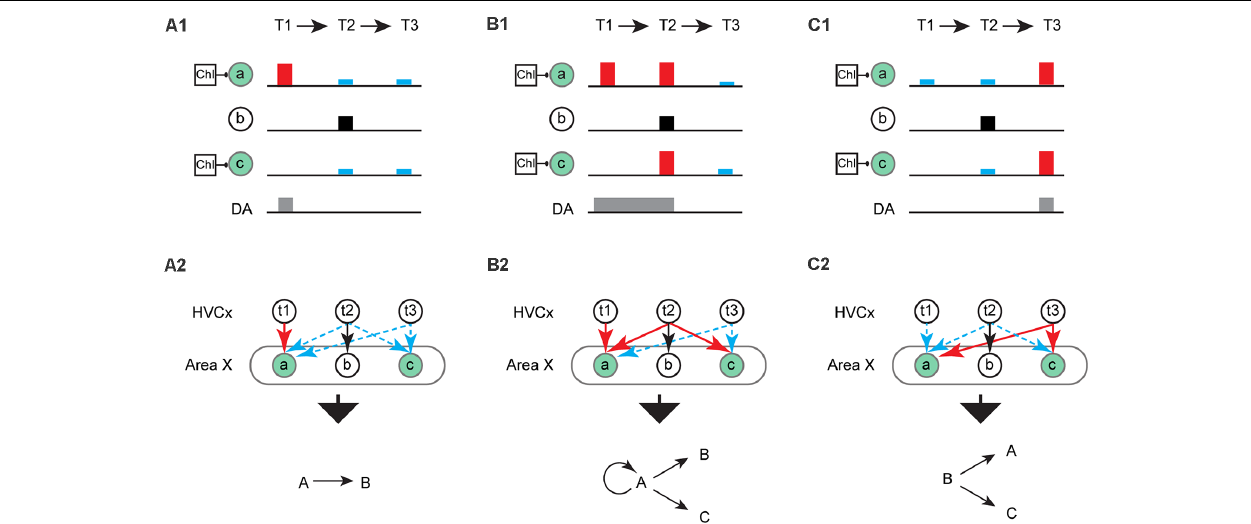
FIGURE 3 | Hypothetical scenarios for learning syllable transitions. (A) A hypothetical scenario in which ChIs pauses are coincident with activation of ensembles “a” and “c” (green circle) and phasic increases in dopamine (DA, gray rectangle) occurs at T1. (A1) LTP (red rectangle) and LTD (blue rectangle) result at corticostriatal synapses on ensembles “a” and “c”, respectively. There is no change (black square) in the ensemble “b” when MSNs depolarization is not coincident with a pause in ChIs and/or phasic increases in DA. (A2) LTP (red arrow) results at “t1 → a” synapses and LTD (blue dashed arrow) results at “t2/3 → a” and “t2/3 → c” synapses. Syllable “A” and “C” are omitted frequently at T2 and T3, resulting in reinforcement (learning) of the syllable sequence “A → B”. (B) Same as (A) but DA is active at T1 and T2 (B1) . (B2) Syllable “A” and “C” are omitted frequently at T3 due to the LTD at “t3 → a/c” synapses. Consequently, the production of syllable sequences “A → A”, “A → C” or “A → B” is reinforced. (C) Same as (A) but DA is active at T3 (C1) . (C2) Syllable “A” is omitted frequently at T1 due to the LTD induced at “t1 → a” synapses. Consequently, the production of syllable sequences “B → A” or “B → C” are